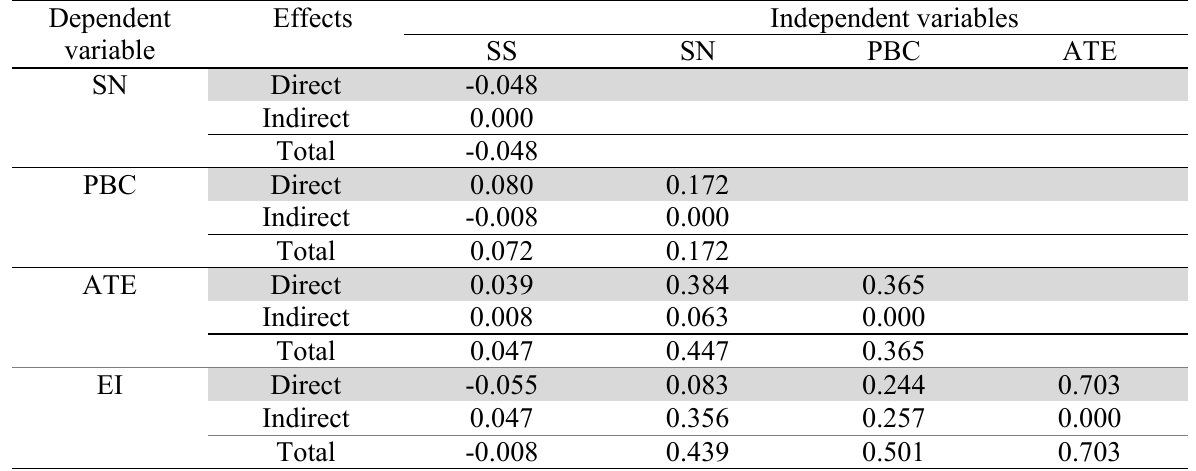
Total effects of variables